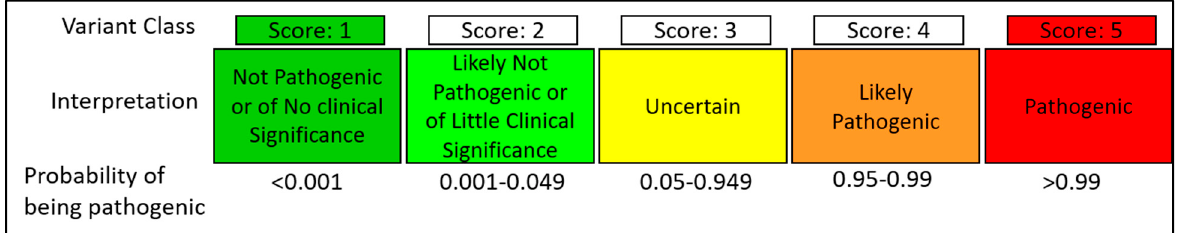
Figure 7. IARC proposed a classification system for BRCA2 sequence variants identified by genetic testing.